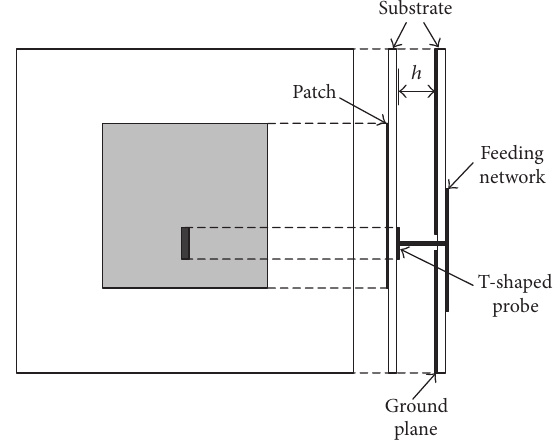
Figure 7: Layout of the T-shaped probe coupled